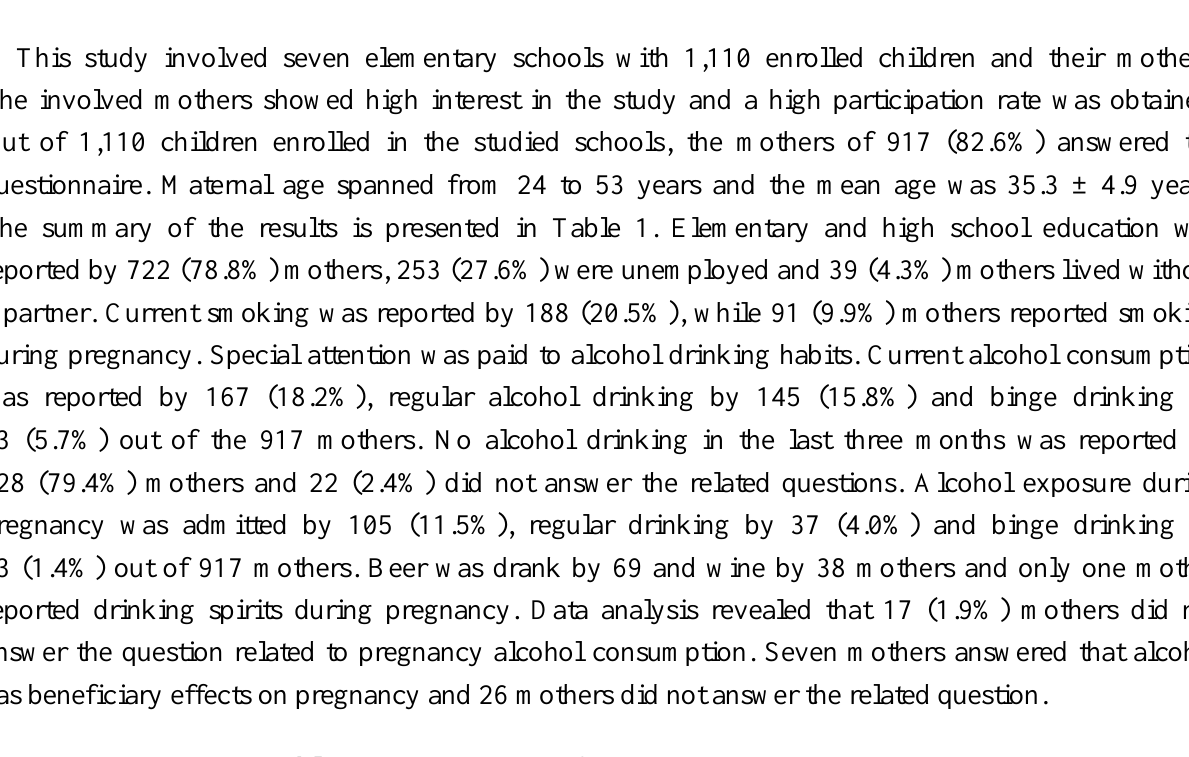
Table 1. Characteristics of the 917 interviewed